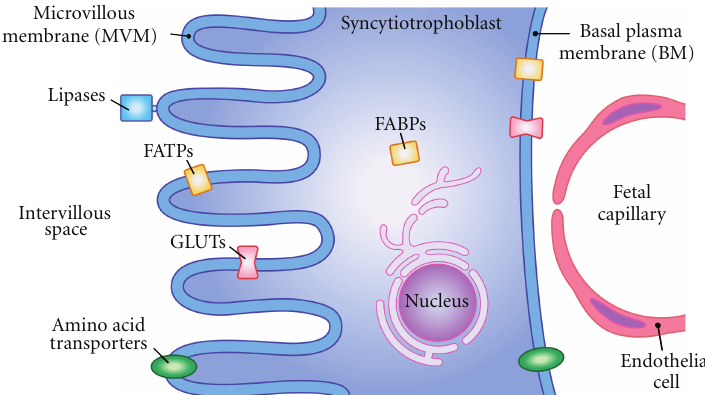
Figure 1: The syncytiotrophoblast represents the primary barrier for transfer of nutrients from mother to fetus. Maternal blood pools in the intervillous space and bathes the microvillous membrane (MVM). The basal plasma membrane (BM) of the syncytiotrophoblast is oriented toward the fetal circulation. Transporters mediating the transfer of amino acids, glucose (GLUTs), and fatty acids (FATPs) are expressed in both plasma membranes of the syncytiotrophoblast. For transfer of lipids, extracellular lipases release fatty acids from maternal lipoproteins and intracellular binding proteins (FABPs) guide the fatty acids within the cytosol of the